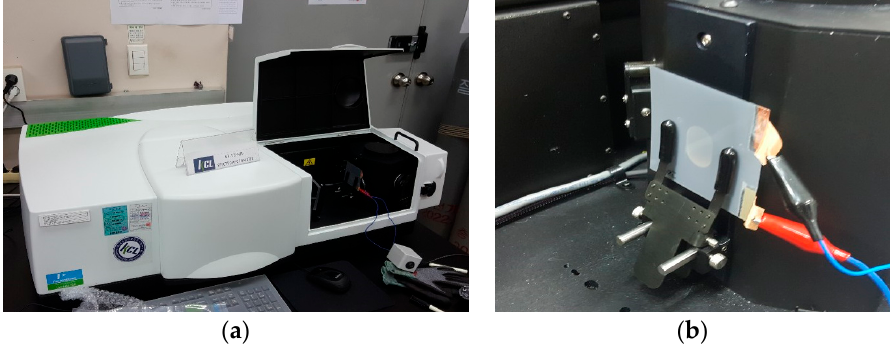
Figure 2. Spectrometer ( a ) and polymer dispersed liquid crystal (PDLC) film specimen ( b ).